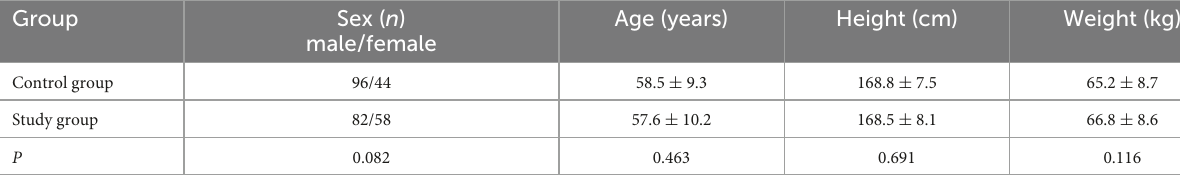
TABLE 1 General situation of both groups.